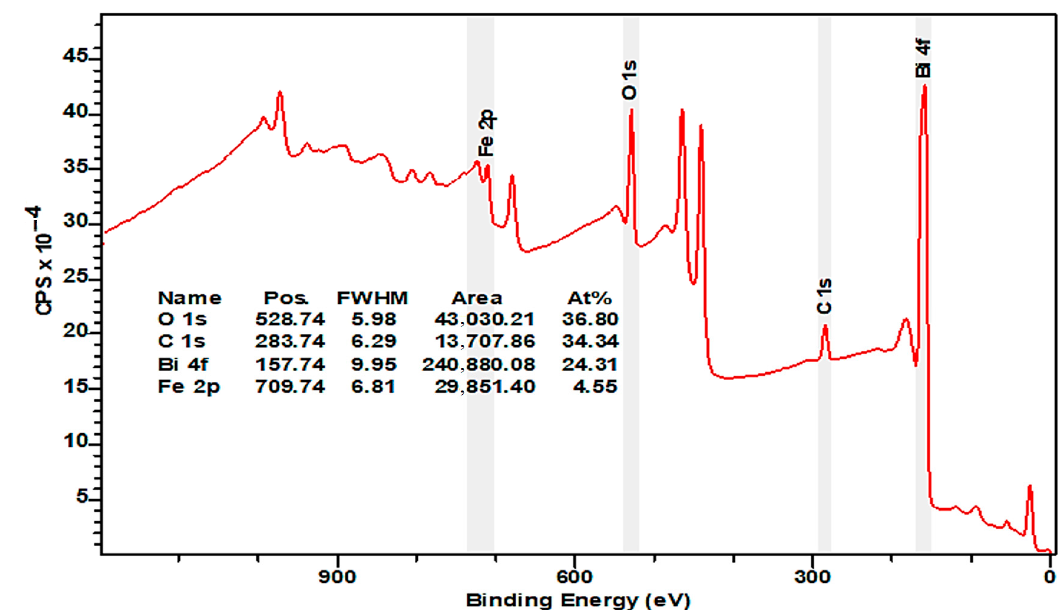
Figure 5. Wide XPS spectrum of 100 nm BFO (Pt/Ti/Si) sample.